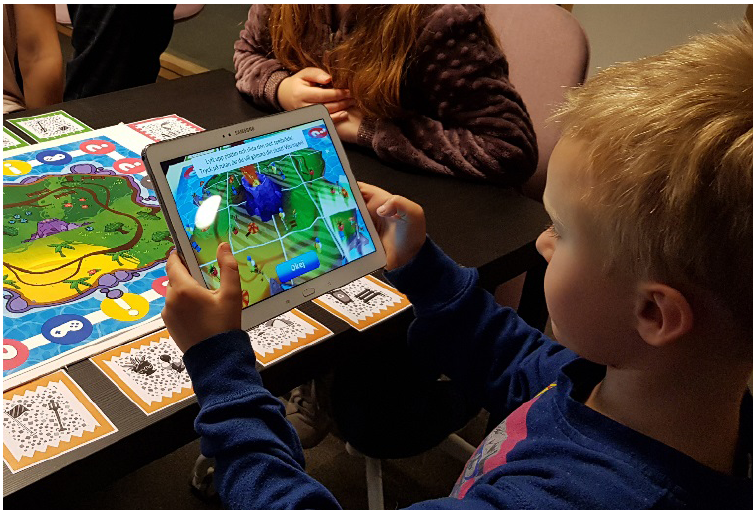
Figure 1. The game includes analogue and digital game parts, and here the tablet shows the board game as a